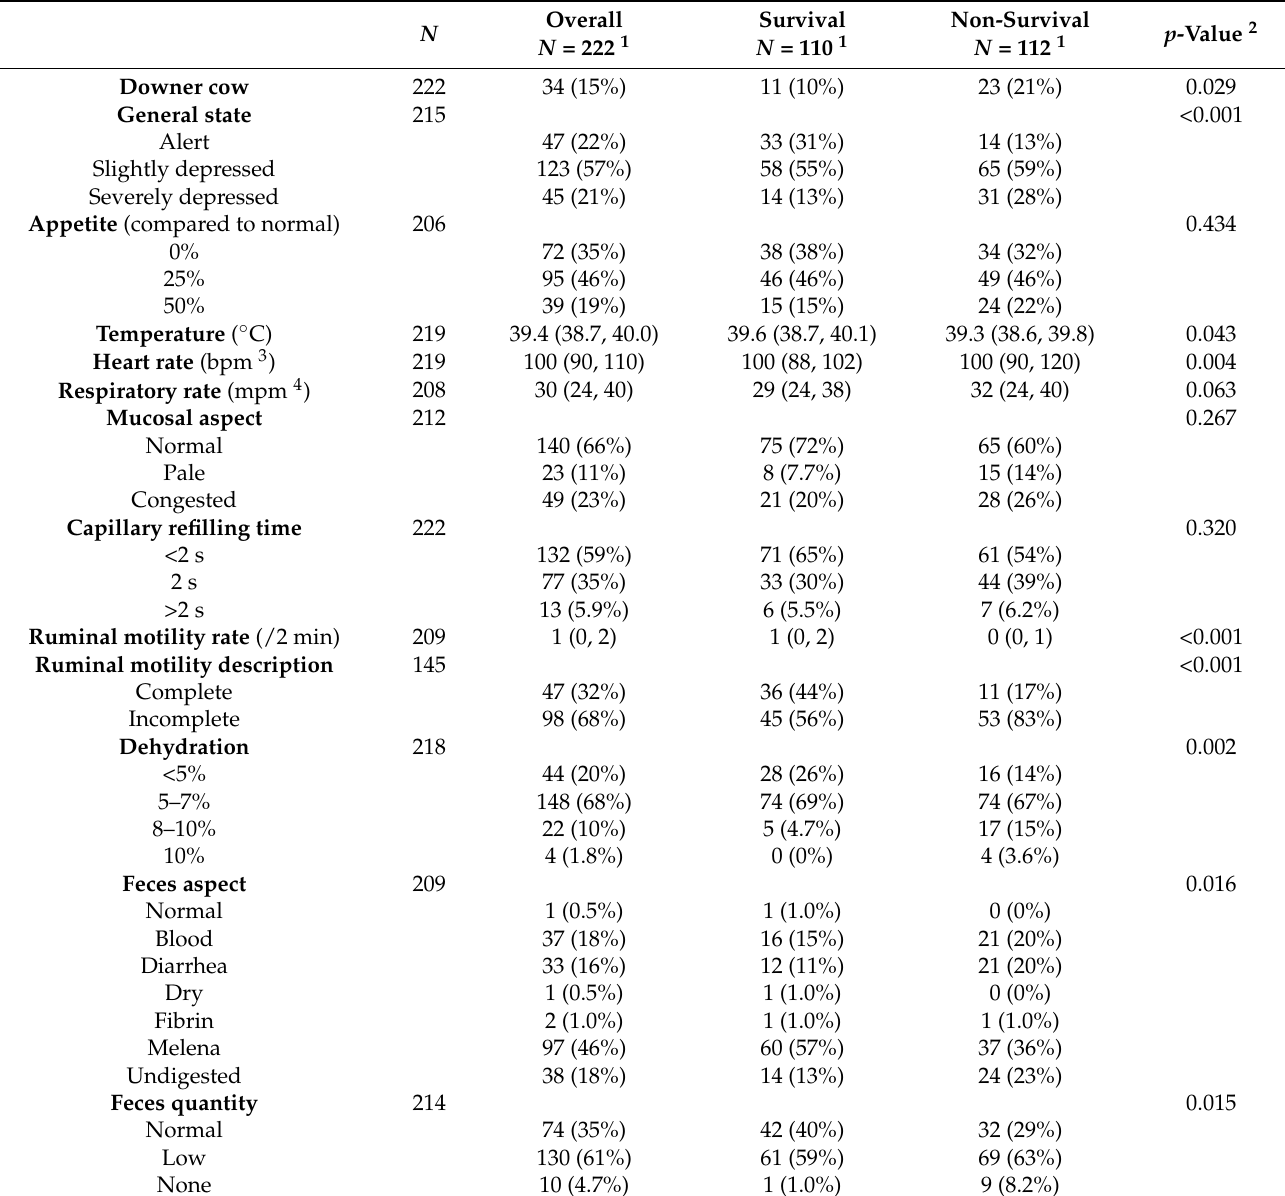
Table 1. Descriptive statistics (overall and stratified by survival status) of clinical examination data from dairy cows (124 herds) affected by severe clinical mastitis in Qu é bec, Canada.